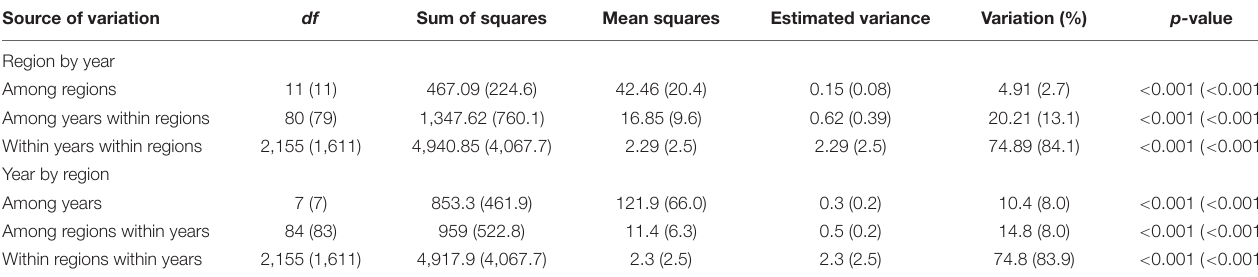
TABLE 4 | Analysis of molecular variance for comparing Puccinia striiformis f. sp. tritici isolates for two different hierarchies: year within region and region within year a . Source of variation